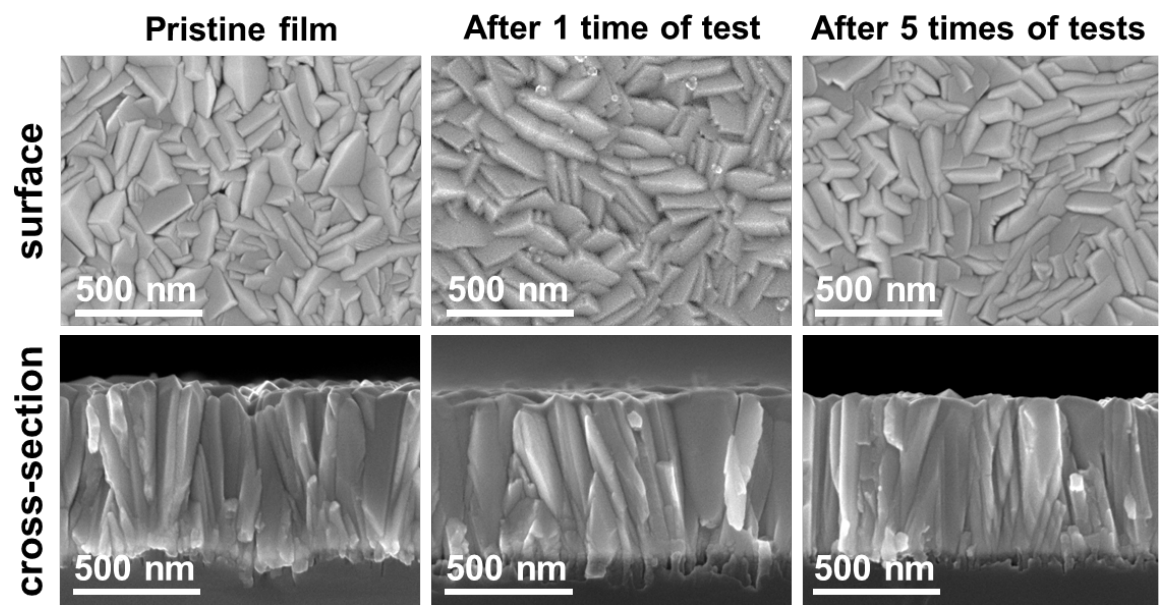
Figure 7. Surface and cross-section SEM images of the WTi alloy film with 6.8 at.% Ti after cycled- thermal-resistance measurements.